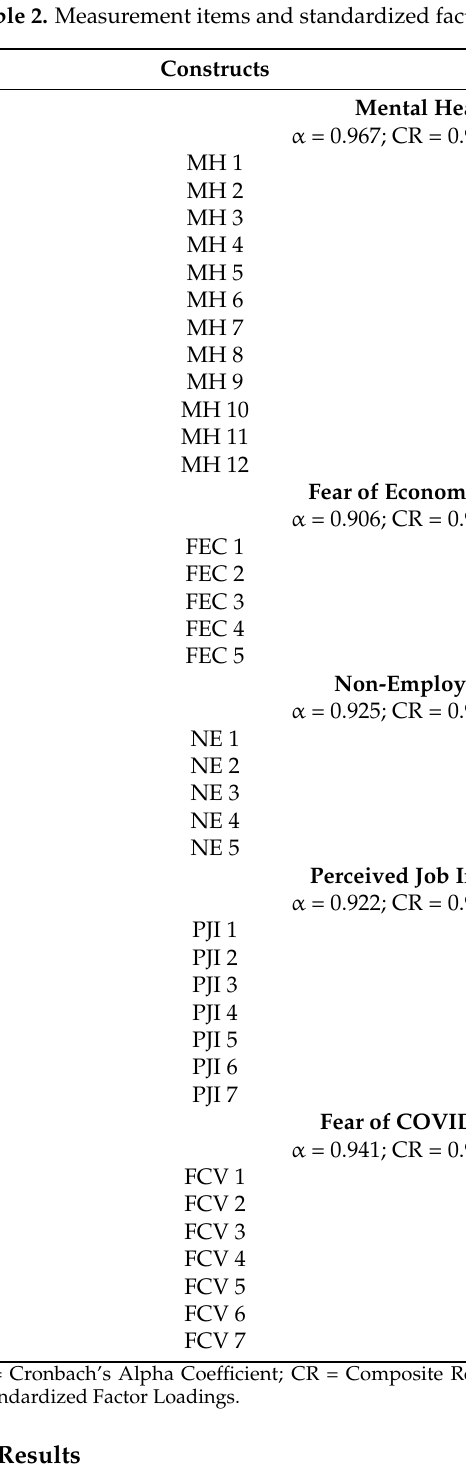
12 items: 6 for anxiety and depression, 4 for social dysfunction, and 2 for loss of confidence.